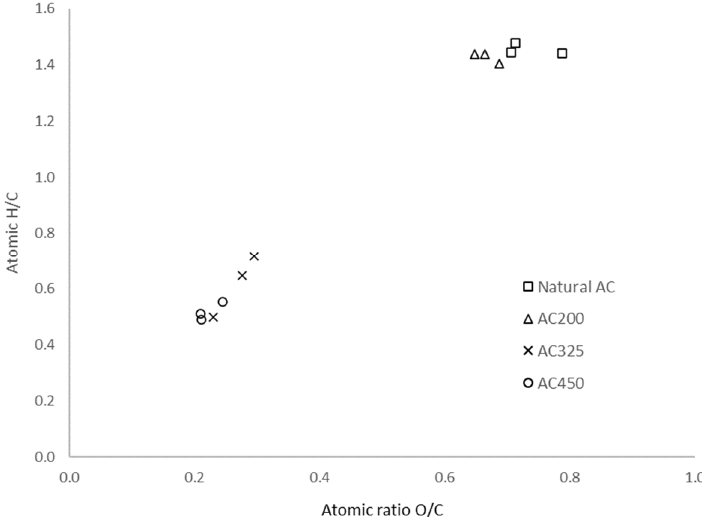
Figure 1. Van Krevelen diagram of uncharred endocarps of different particle sizes and derived from Acrocomia , as well as the respective material pyrolyzed at 200 °C, 325 °C and 450 °C.